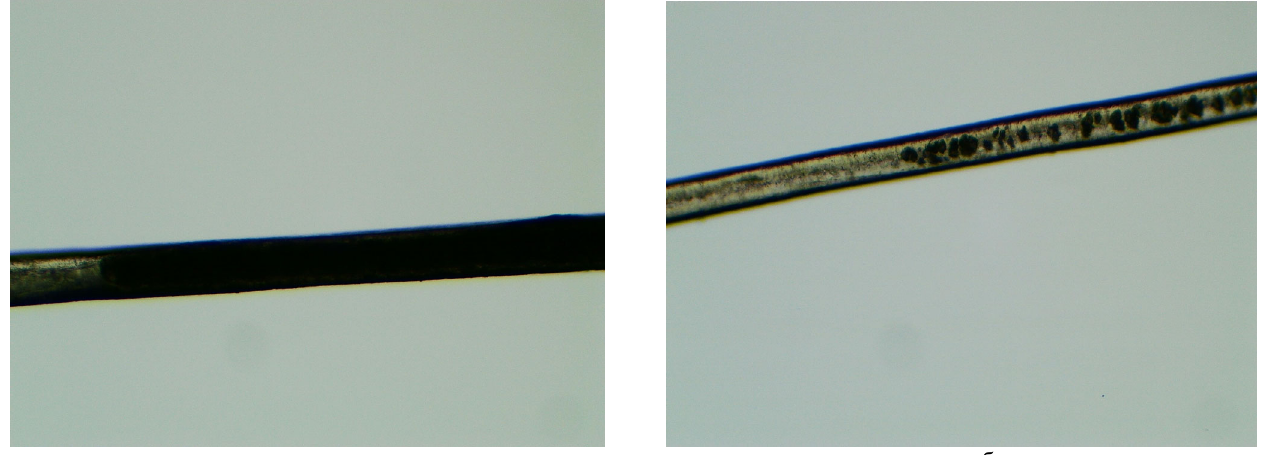
Figure 2. Donkey hair ( Equinus asinus ): а – mane; b – covering hair; х